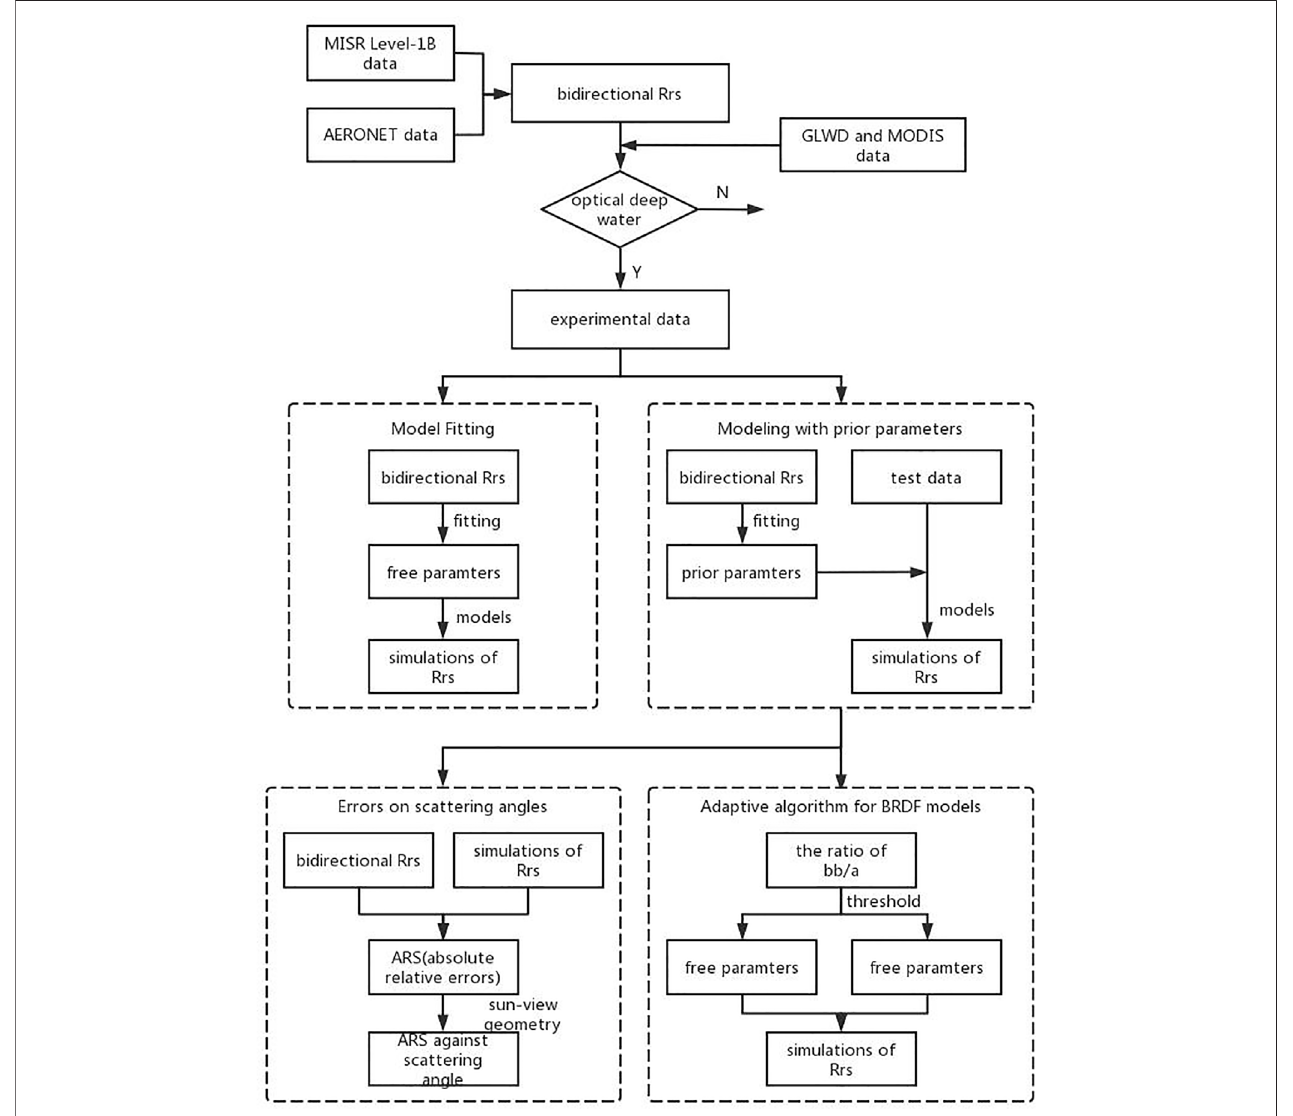
FIGURE 4 | Flowchart of this